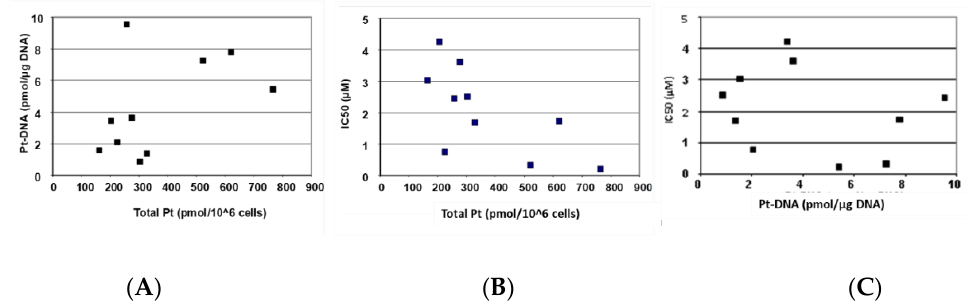
Figure 3. Relationship between total platinum accumulation, platinum DNA adducts formation, and sensitivity towards oxaliplatin in parental and oxaliplatin resistant cell lines. ( A ) Scatter plot of total platinum accumulation (pmol / 10 6 cells) and formation of platinum DNA adducts (pmol / µ g DNA), ( B ) scatter plot of total platinum accumulation (pmol / 10 6 cells) and sensitivity ( µ M) towards oxaliplatin and ( C ) scatter plot of platinum DNA adducts formation (pmol / µ g DNA) and sensitivity ( µ M) towards oxaliplatin. The IC50 values are taken from Table 1 and total platinum accumulation and platinum DNA adducts are from Figure 2. Table 2. Correlation between quantitative gene expression data with total platinum accumulation, DNA adduct formation, and sensitivity to oxaliplatin. Pearson